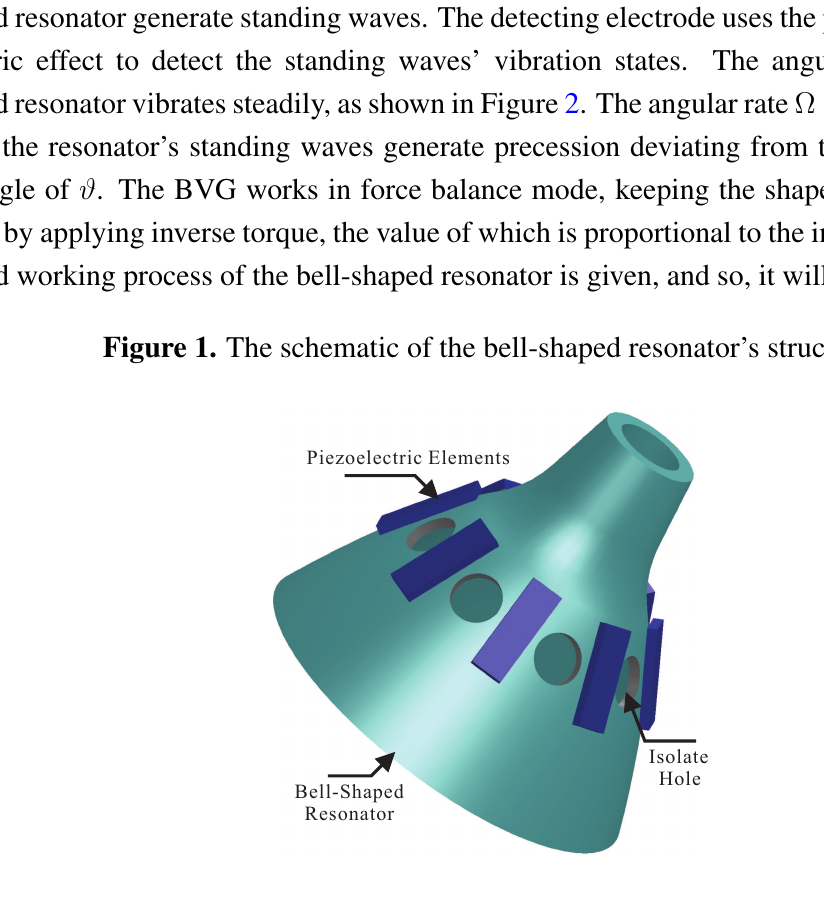
Figure 2. The schematic of the working principle. ( a ) Primary Mode; ( b ) Second